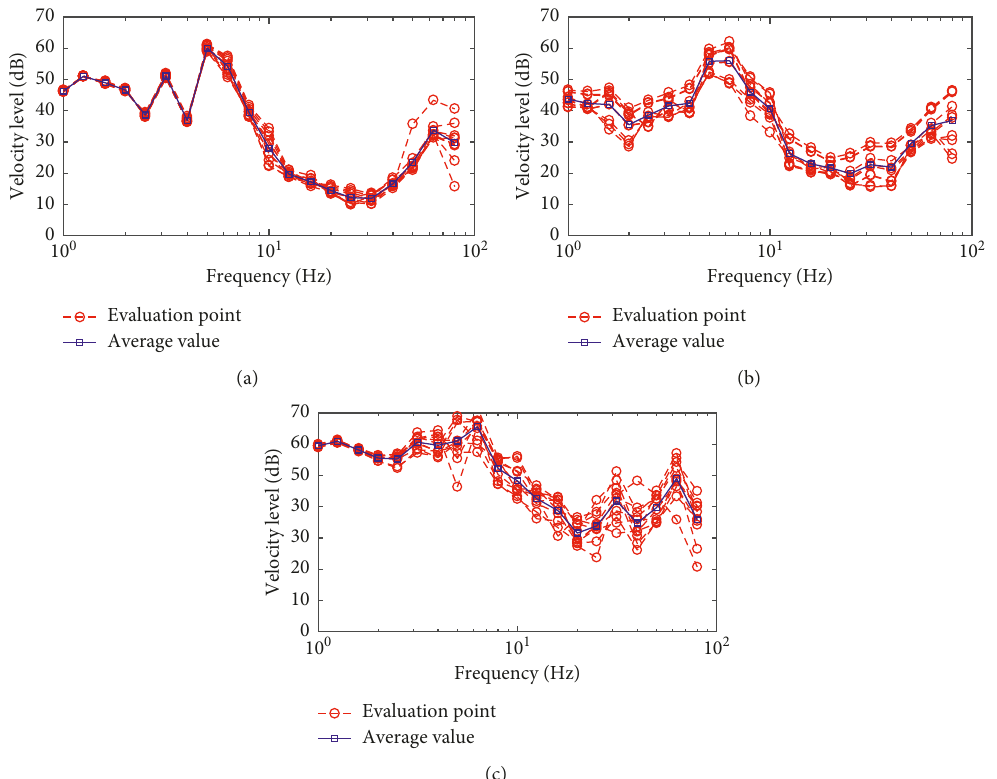
Figure 19: The 1/3 octave frequency band velocity level of the typical story (6 th story, damping ratio (c) Z direction.